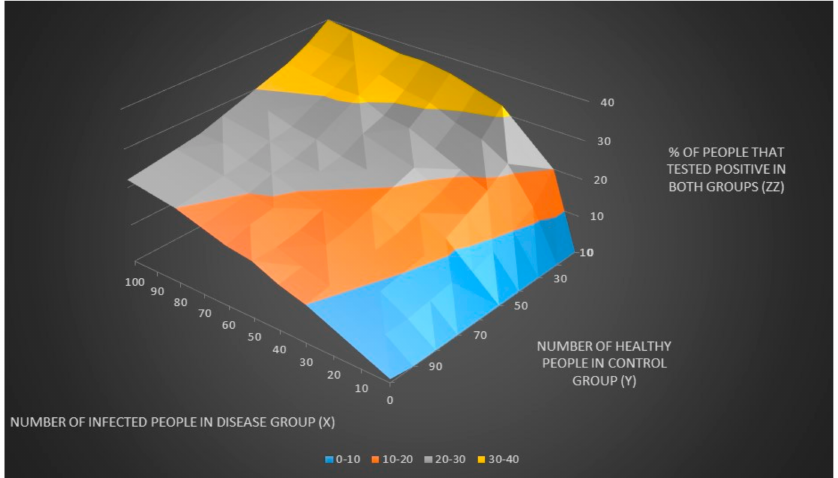
Figure 2. The % number of people that tested positive in both groups (zz) when the number of infected people in the disease group (x) and the number of healthy people in control groups (y) are